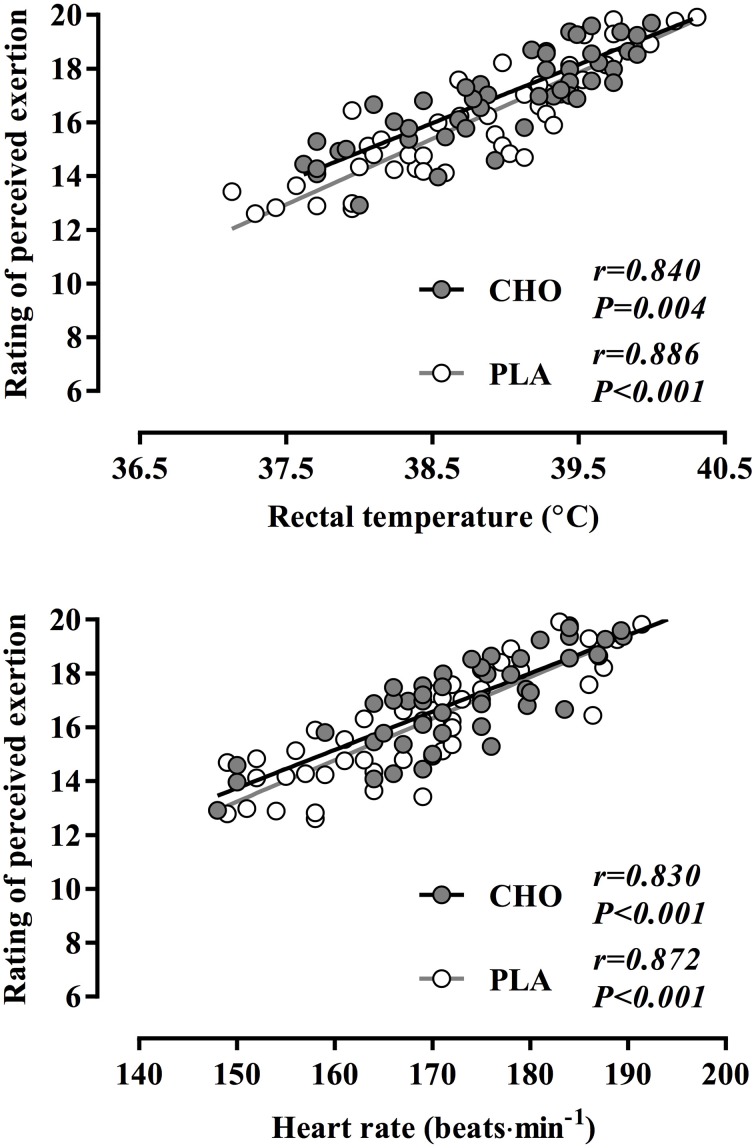
Rating of perceived exertion plotted against rectal temperature (i.e., thermal strain) and heart rate (i.e., cardiovascular strain) during a 40-km cycling time trial in hot and humid conditions while rinsing the oral cavity with a carbohydrate solution (CHO) or taste- and color-matched placebo (PLA).